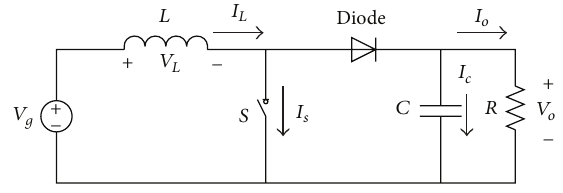
Figure 4: The boost converter.